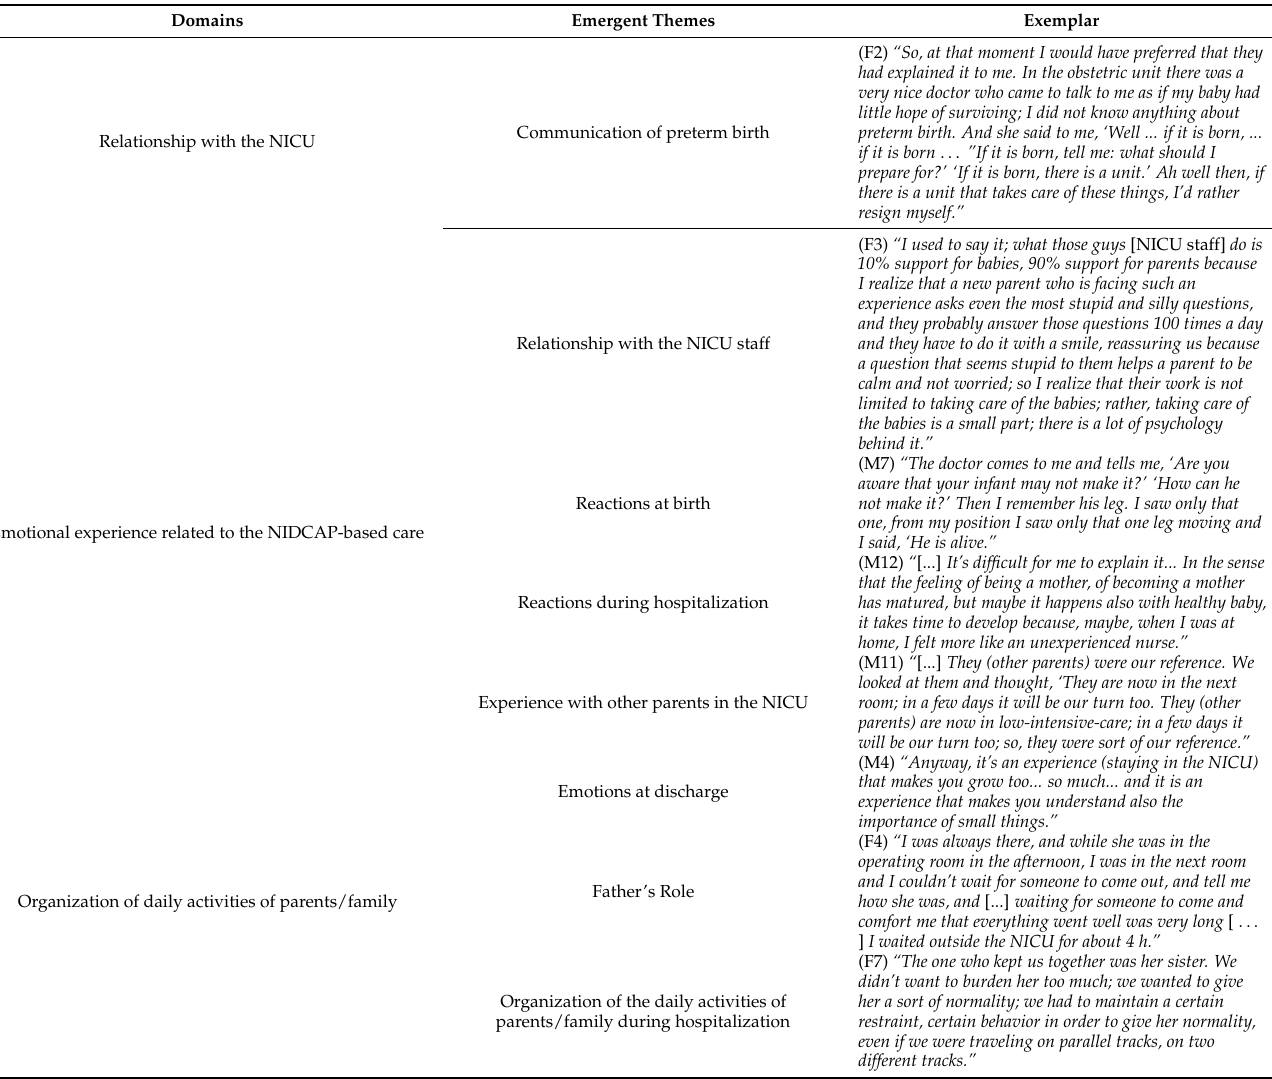
Table 2. Sub-themes